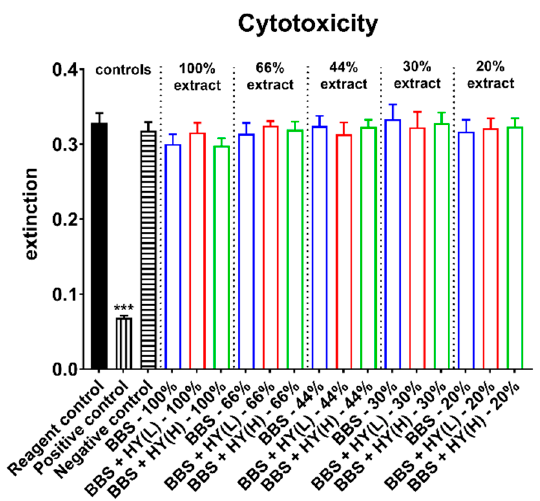
Figure 1. Results of the cell viability measurements of L929 fibroblasts used as measure for cytotoxicity (*** p <